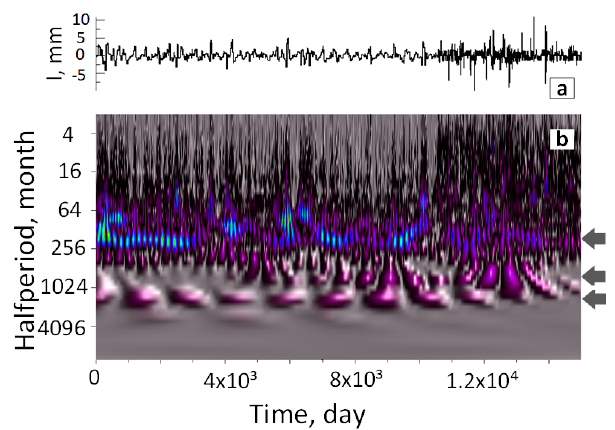
Figure 14. Wavelet-periodogram ( b ) of long-term (1980–2017) observations of infiltration cyclicity (day amount, mm) for GWT = 2.5–3.8 m ( a ). Cyclicity periods: top arrow—1 year, middle arrow—5–6 years, lower arrow—8 years.